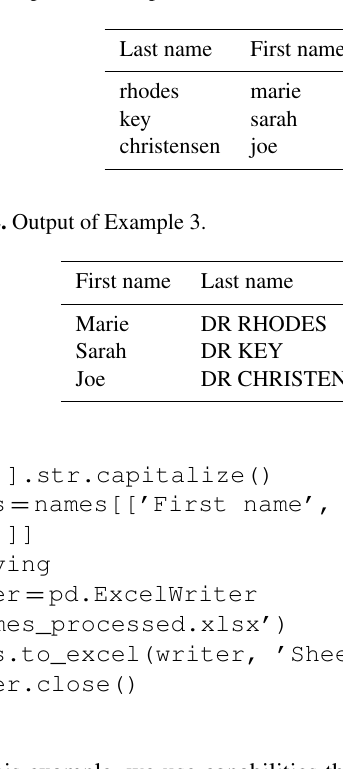
Table 1. Input for Example 3.